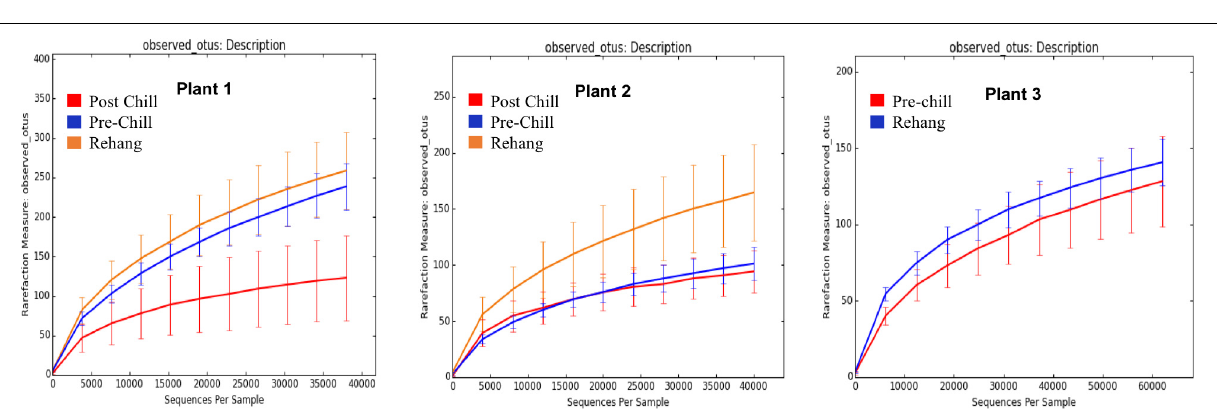
Frontiers in Microbiology |